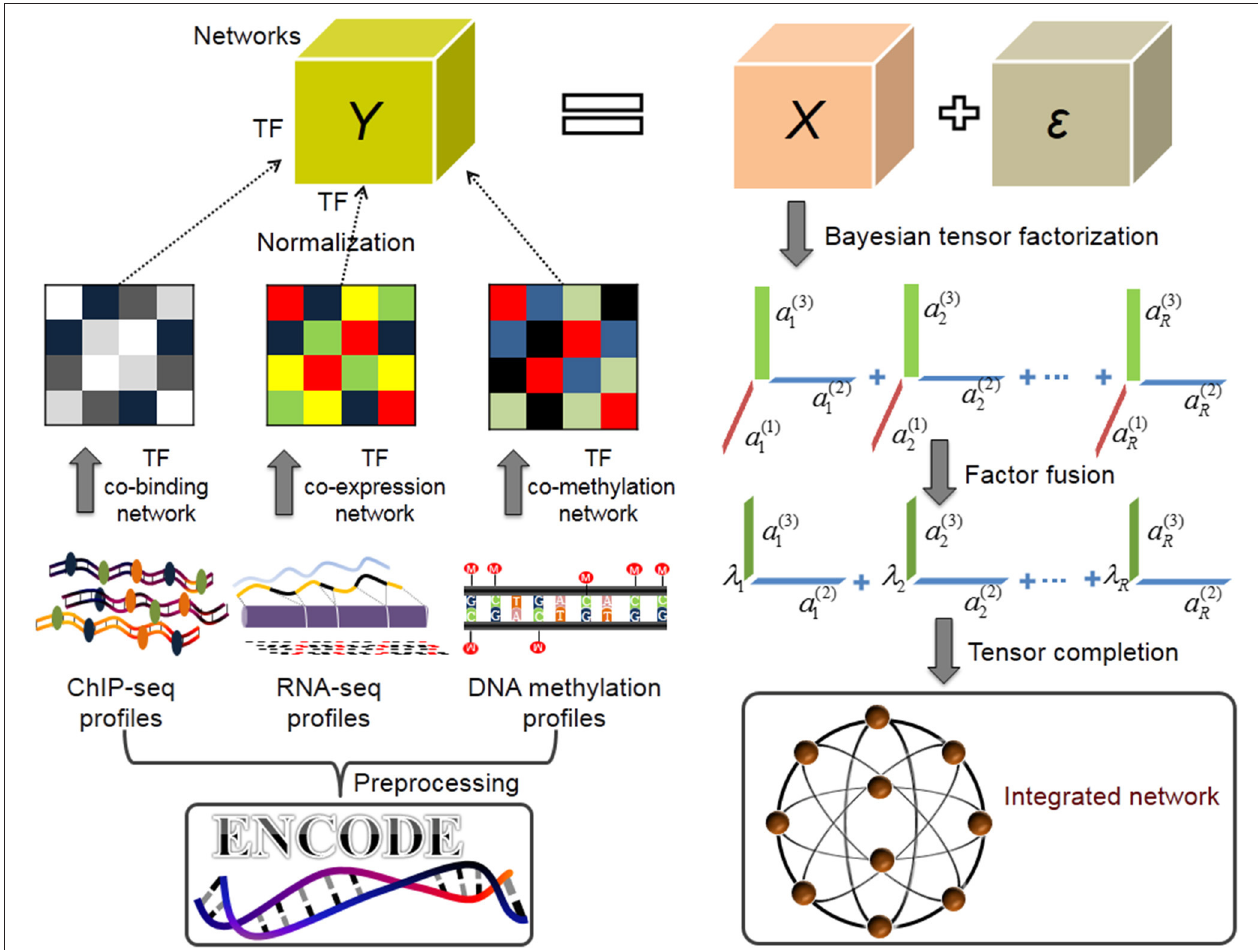
FIGURE 1 | Overview of inferring TF combinatorial interactions (Application I). After data preprocessing, we first merge overlapping binding sites of the same TF in various conditions based on 155 TFs ChIP-seq datasets from ENCODE project and get the discrete, non-redundant genome binding region for each TF. We then construct a co-binding network by calculating the percentage of significant overlaps between the non-redundant binding sites of each pair of TFs, and build co-expression and co-methylation networks using PCC, respectively. We normalize the three networks respectively and stack them into a tensor. We next infer the multilinear factors over the tensor using BCPF. Finally, we fuse factors of network dimensions into a weight vector λ i , ∀ i ∈ [1, R ] for every rank-one matrix of TF interactions and obtain a weighted TF interaction